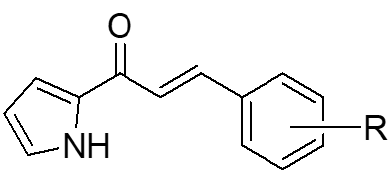
Figure 1. Molecular structure of chalcone